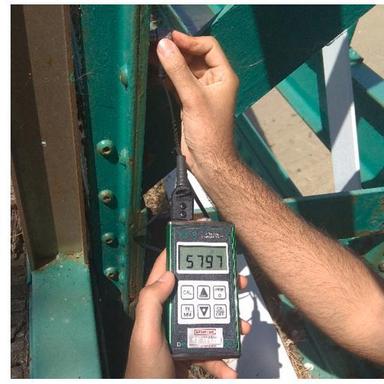
Ultrasonic testing: measurement of the velocity of propagation of the longitudinal waves.